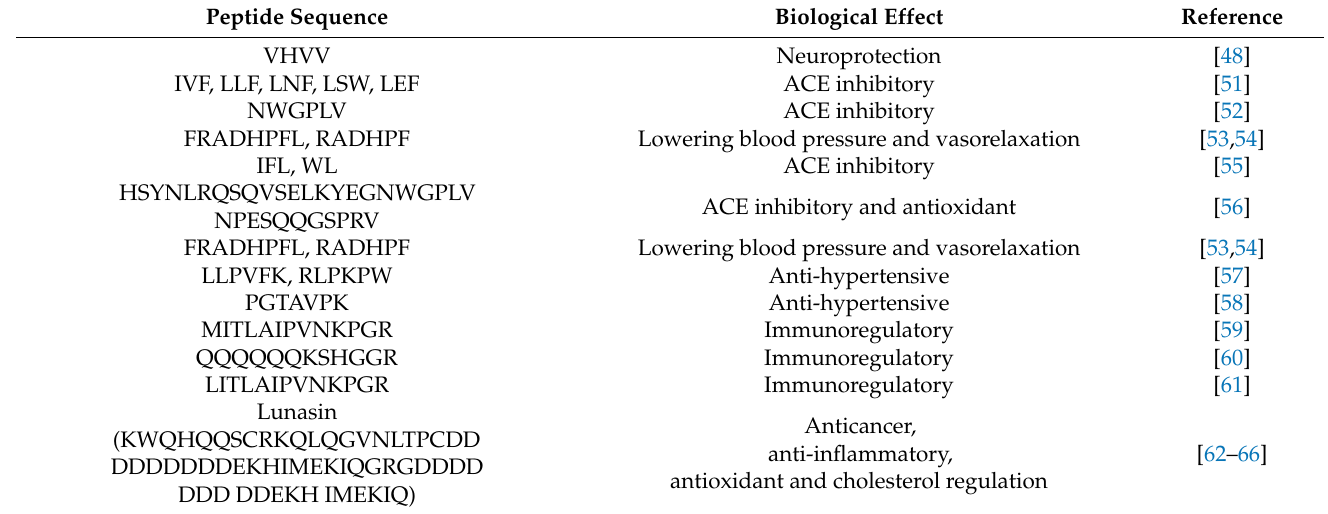
Table 1. Representative beneficial effects of soybean-derived bioactive peptides in humans. Peptide